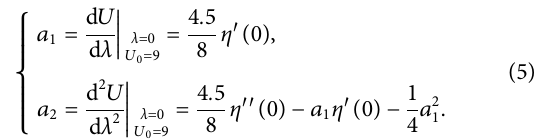
FIGURE 2 | Variation curve of the continuous interruption function η ( λ ).